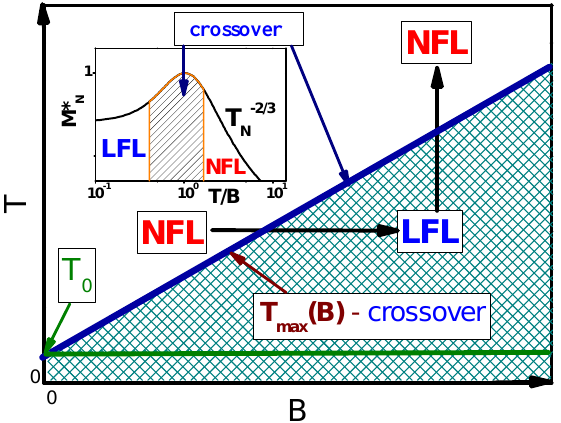
Figure 8. Schematic T − B phase diagram of Lu 3 Cu 2 Sb 3 O 14 with magnetic field as the control parameter. The vertical and horizontal arrows depict LFL-NFL transitions at fixed B and T , respectively. The line separating LFL-NFL regions is shown by the arrow, representing the crossover region at T max ( B ) and displaying the function T max ( B ). T 0 is the tem- perature at which the LFL behavior occurs. The inset demon- strates a chart of the normalized effective mass M ∗ as a func- tion of T N T/B . Transition region is characterized by the ∝ maximum value M ∗ of M ∗ at T N = T/T max = 1. max